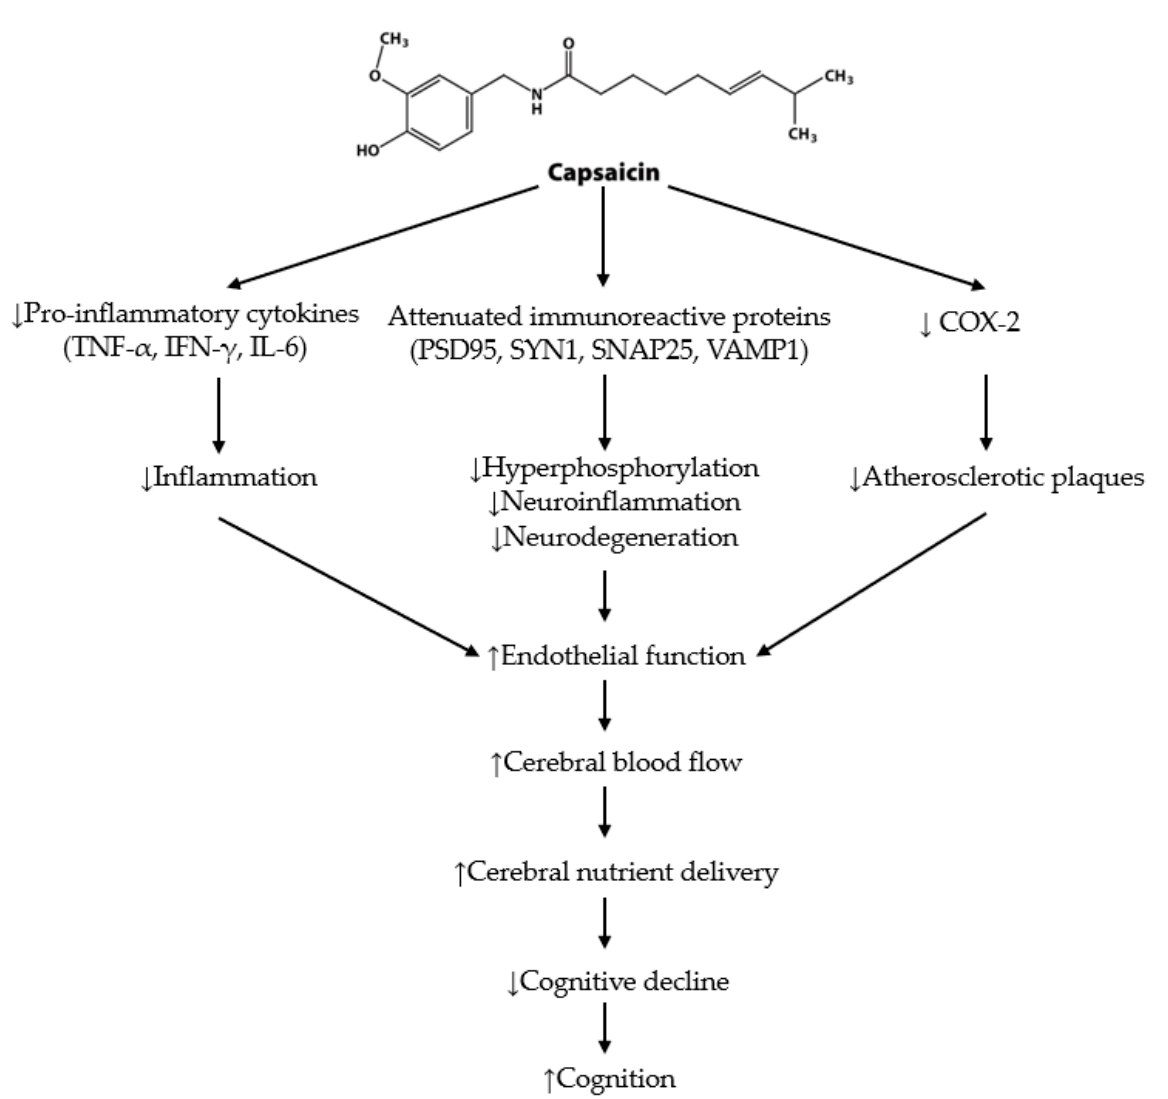
Figure 4. Schematic representation of the neuroprotective effects of capsaicin in animals. This figure demonstrates the capacity of capsaicin to increase CBF, therefore increasing the delivery of nutrients to the brain, a key factor in the prevention of cognitive decline and improved cognition [10,26,43]. Capsaicin decreases pro-inflammatory cytokines, including tumour necrosis factor-alpha (TNF- α ), interferon-gamma (IFN- γ ) and interleukin-6 (IL-6), reducing inflammation [27,108]. Attenuation of immunoreactive proteins, including postsynaptic density protein 95 (PSD95), synapsin-1 (SYN1), synaptosomal-associated protein 25 (SNAP25) and antivesicle-associated membrane protein 1 (VAMP1), contribute to reducing hyperphosphorylation, neuroinflammation and neurodegeneration [27]. Capsaicin also reduces the action of cyclo-oxygenase (COX-2), which prevents atherosclerotic plaque formation [146,147]. These changes can lead to improved endothelial function, CBF and, in turn, cognition [27,146]. Abbreviations: ↑ : increased; ↓ : decreased.